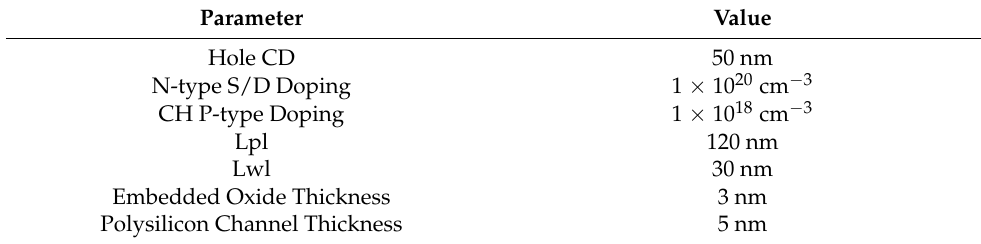
Figure 3. The simulation structure of the conventional DFM and the novel proposed structure. Table 1. Simulation